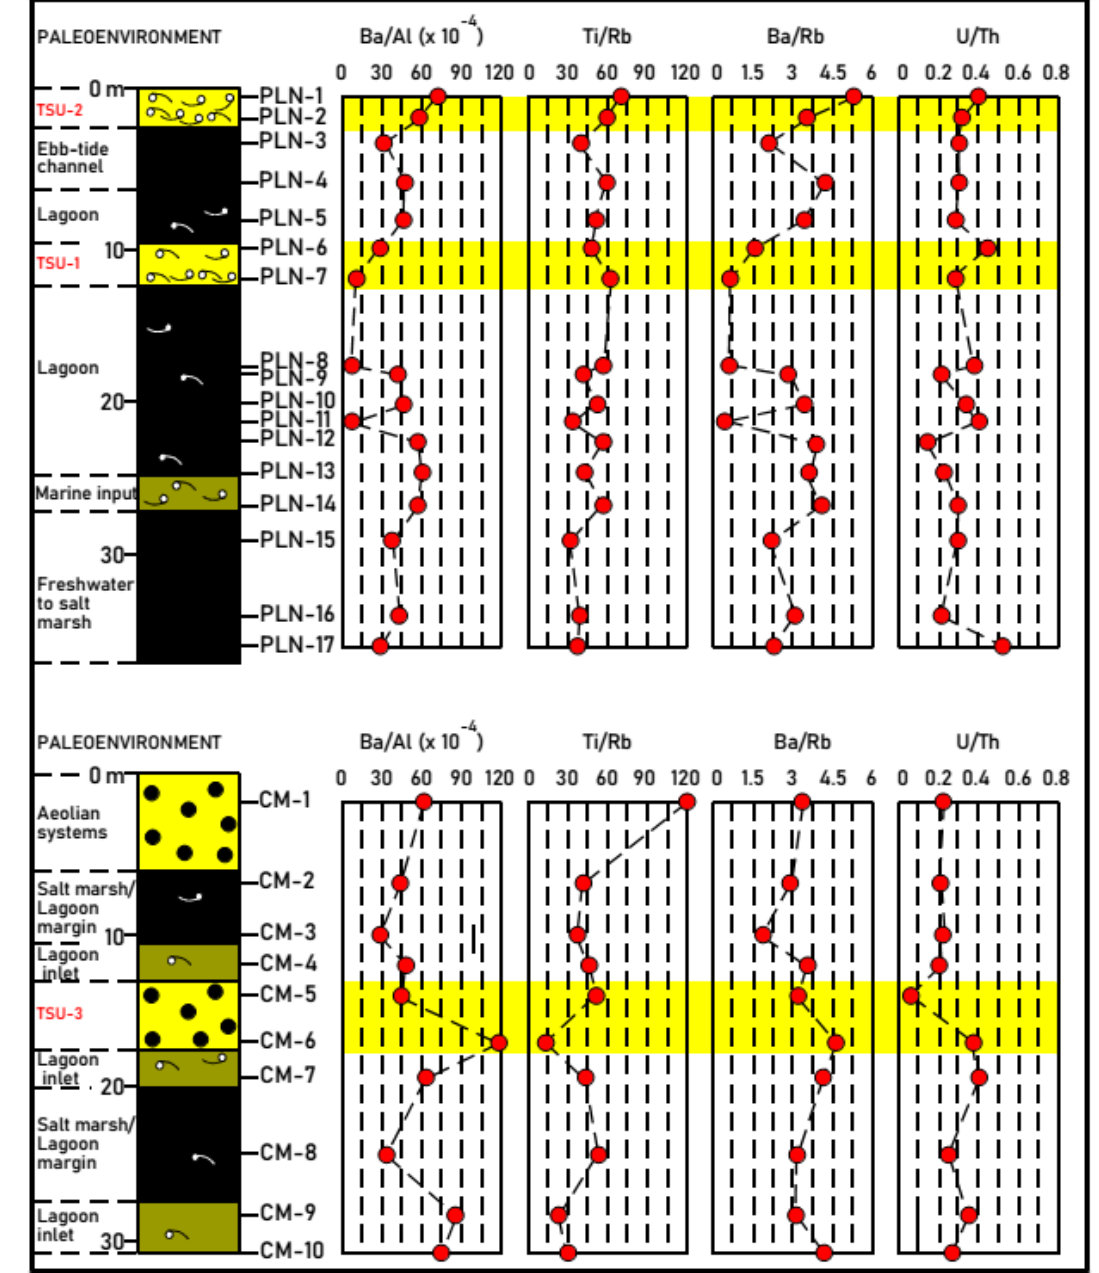
/ Al, Ti / Rb, Ba / Rb and U / Th